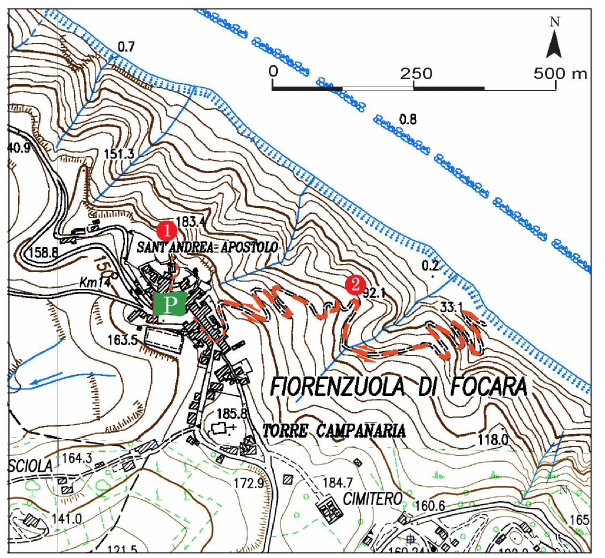
Figure 5. The proposed itinerary, starting from Fiorenzuola di Fo- cara and moving to the beach below. Note: P – parking area; 1 and 2 – stop. © 2020 Marche